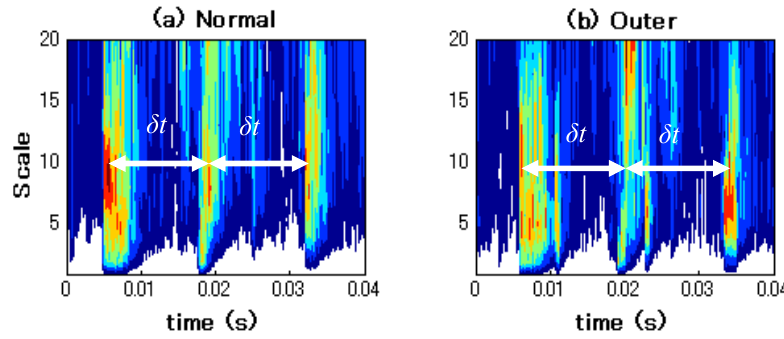
Figure 12. Contour graphs of CWT spectra by Gaussian wavelet. (a) Normal state. (b) Outer- race defect state.